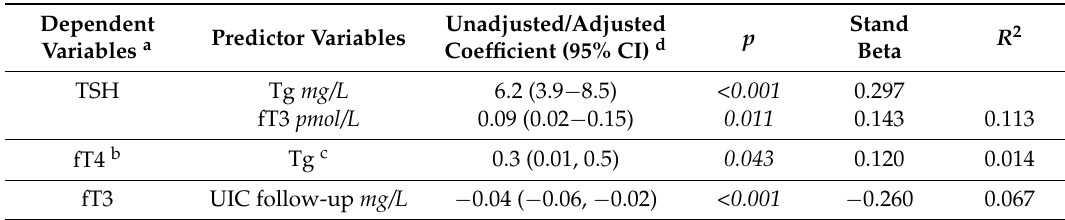
Table 5. Predictors for TSH, fT4 and fT3 ( n = 289).